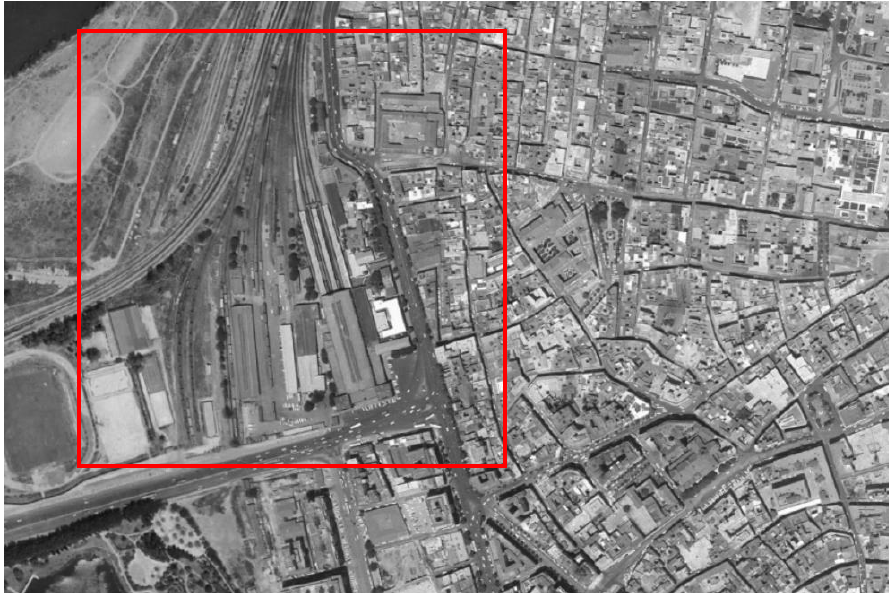
Figure 2. Seville Plaza de Armas railway station (1973–1986). Aerial view From Digital Phototeca. National Geographic Institute.